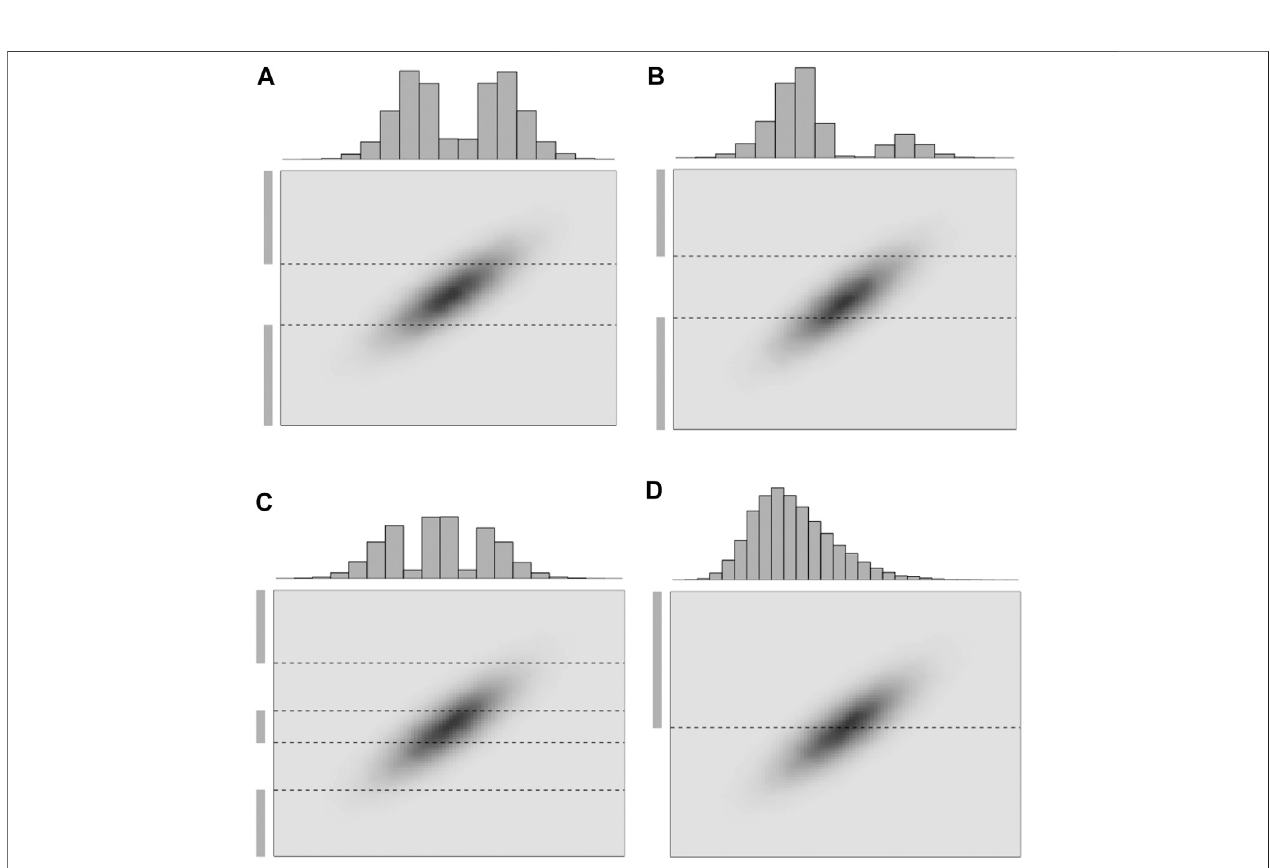
FIGURE 5 | Realizations of 1D selection-Gaussian pdfs (histogram) with varying selection sets A ⊂ R n (solid gray bars) for a bi-Gaussian pdf [ ~ r , ] ] (dark gray).